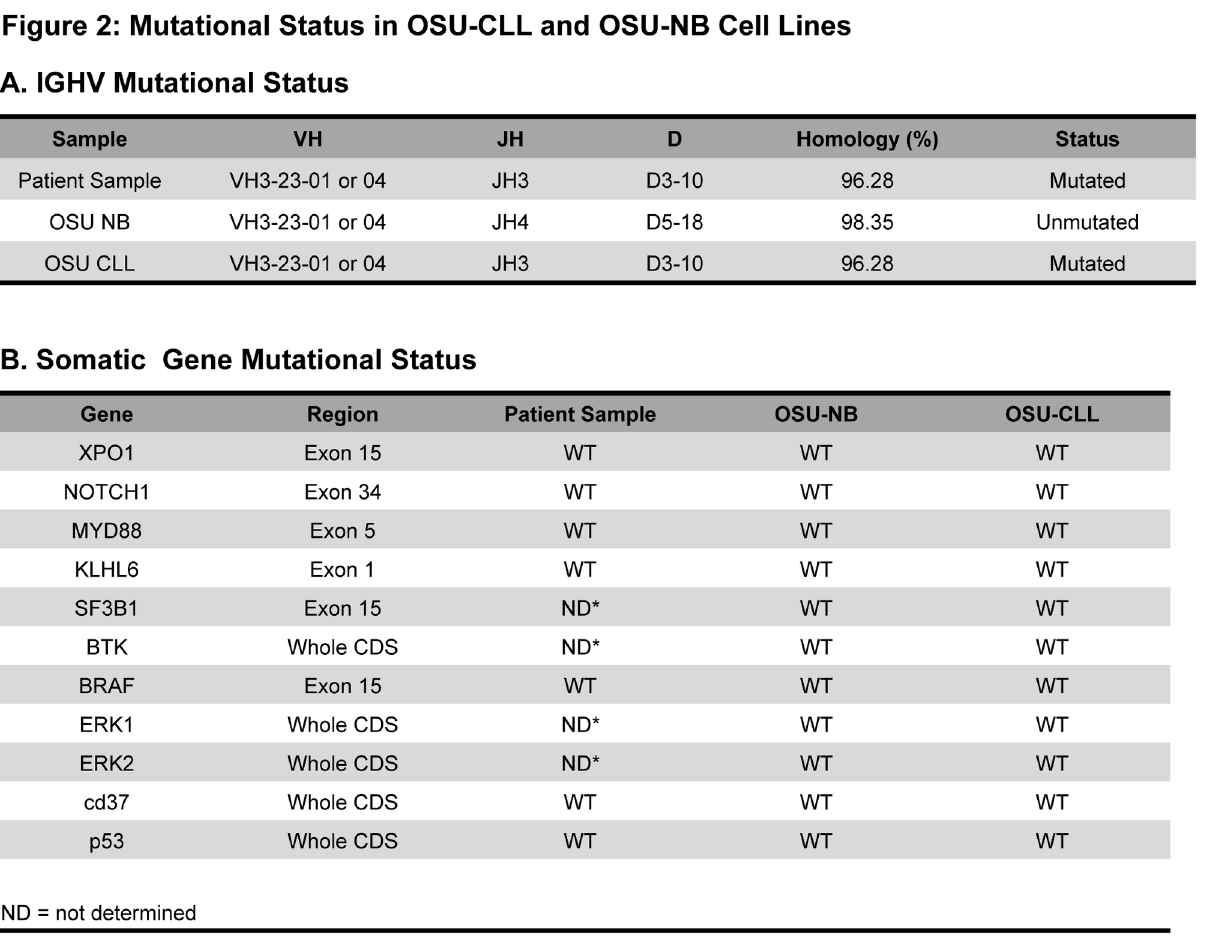
Figure 2. Mutational status in OSU-CLL and OSU-NB cell lines. Analysis is performed in patient sample from which the cell lines were derived as well as cultured cells from both lines (approximate timing: early = 3 months, intermediate = 6 months, late = 9 months). A . IGHV mutational status . Gene mutational status (relative to the reference genome), and immunoglobulin gene usage determined by sequence analysis. B . Somatic gene mutation status . Existence of mutations for common CLL variants was explored by sequence